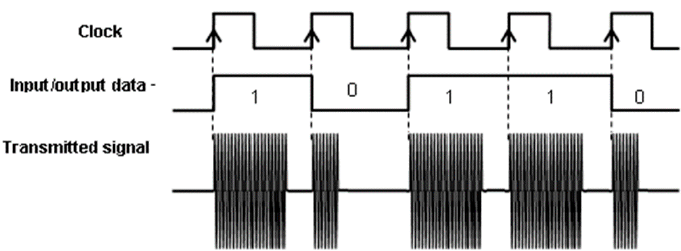
Figure 4. Simplified waveforms for clock, data and pulse width modulation (PWM) modulated RF carrier.